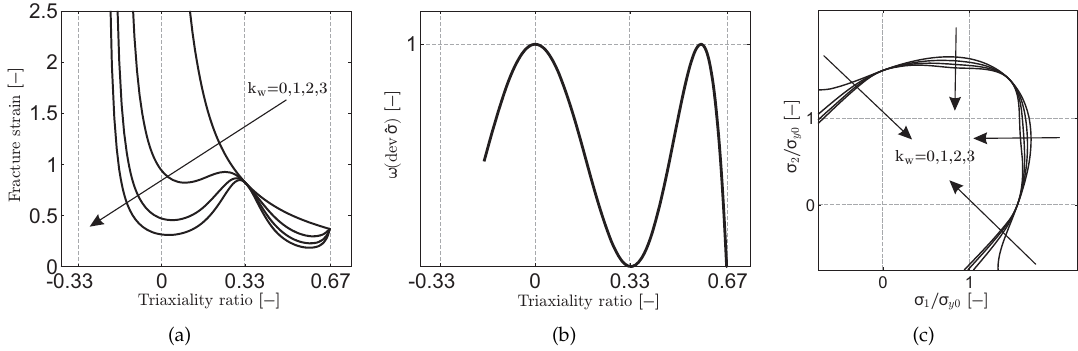
Figure 1. ( a ) The influence of the shear damage parameter k ω on the dependence of fracture strain on triaxiality ratio; ( b ) The plot of the function w ( dev (cid:98) σ ) ; ( c ) Isochronous fracture surfaces for varying k ω in plane stress space. These plots are created by numerically solving the initial boundary value problem for linear and uniform strain paths under plane stress state considering linear isotropic hardening plasticity with hypothetical